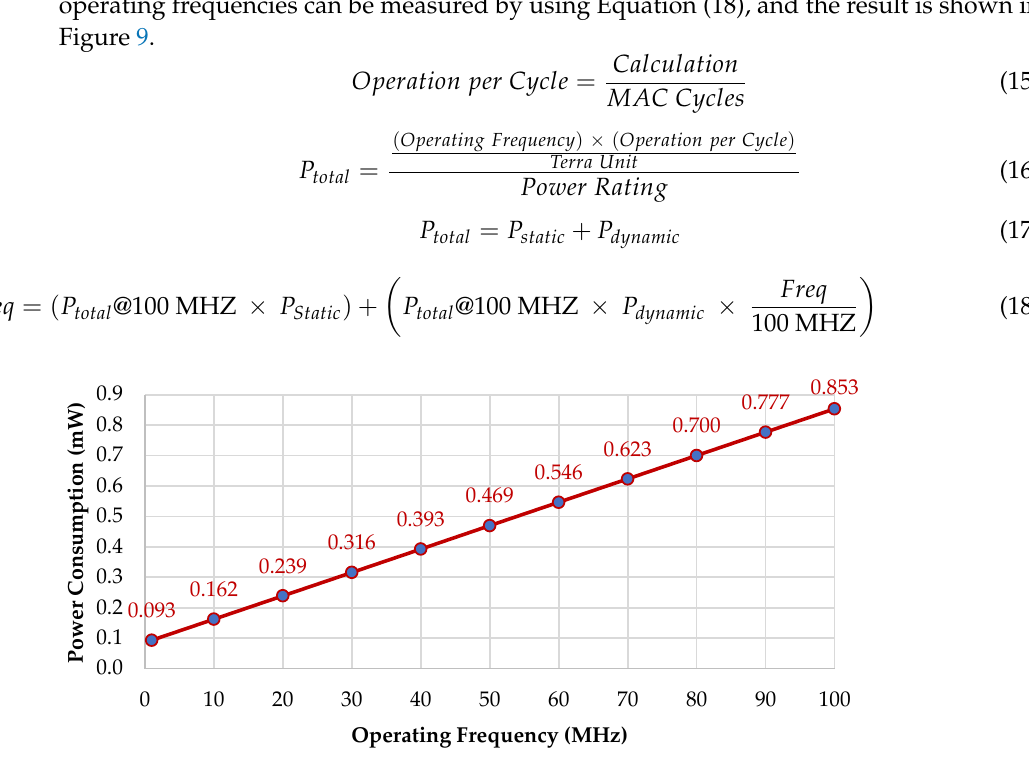
Figure 9. Power consumption across the different operating frequencies.